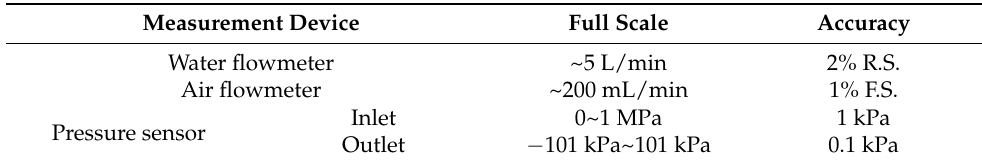
Table 2. The specifications of measurement